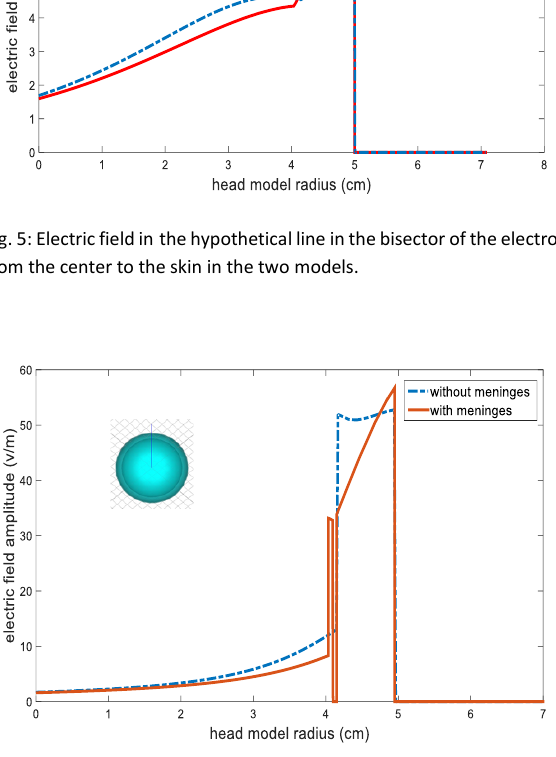
Fig. 6: Electric field in the hypothetical line from the center of the head model to the center of the anode electrode.